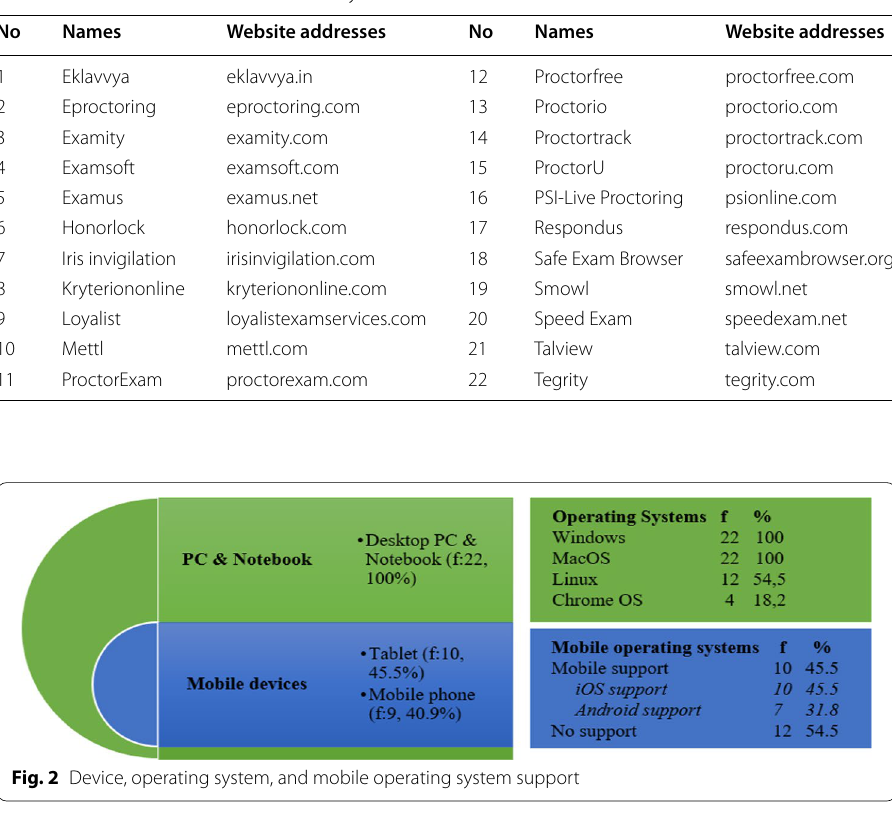
Table 1 Reviewed online assessment systems